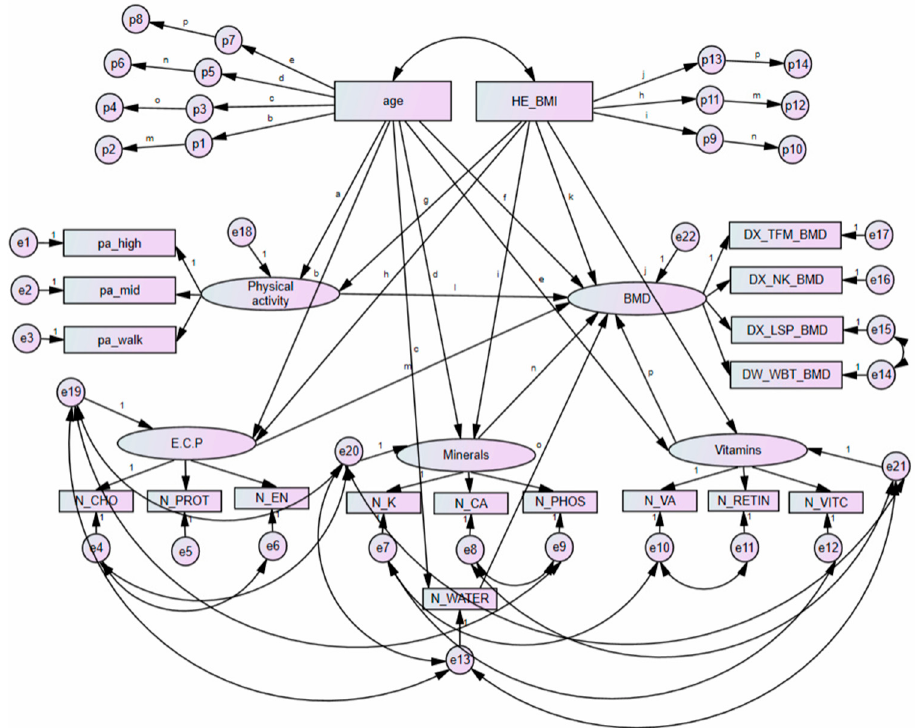
Figure 5. Results of mediated pathways with age, BMI, physical activity, and nutrient intakes in postmenopausal women with bone mineral density. Errors are presented with e1, e2, e3, e4, e5, e6, e7, e8, e9, e10, e11, e12, e13, e14, e15, e16, e17, e18, e19, e20, e21 and e22. Phantom variables